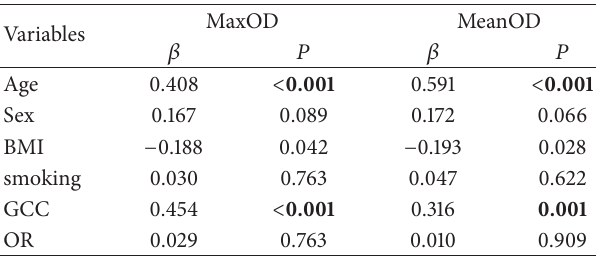
Table 5: Multiple linear regression model showing the relationship between age, sex, BMI, retinal thickness, maxOD, and meanOD.